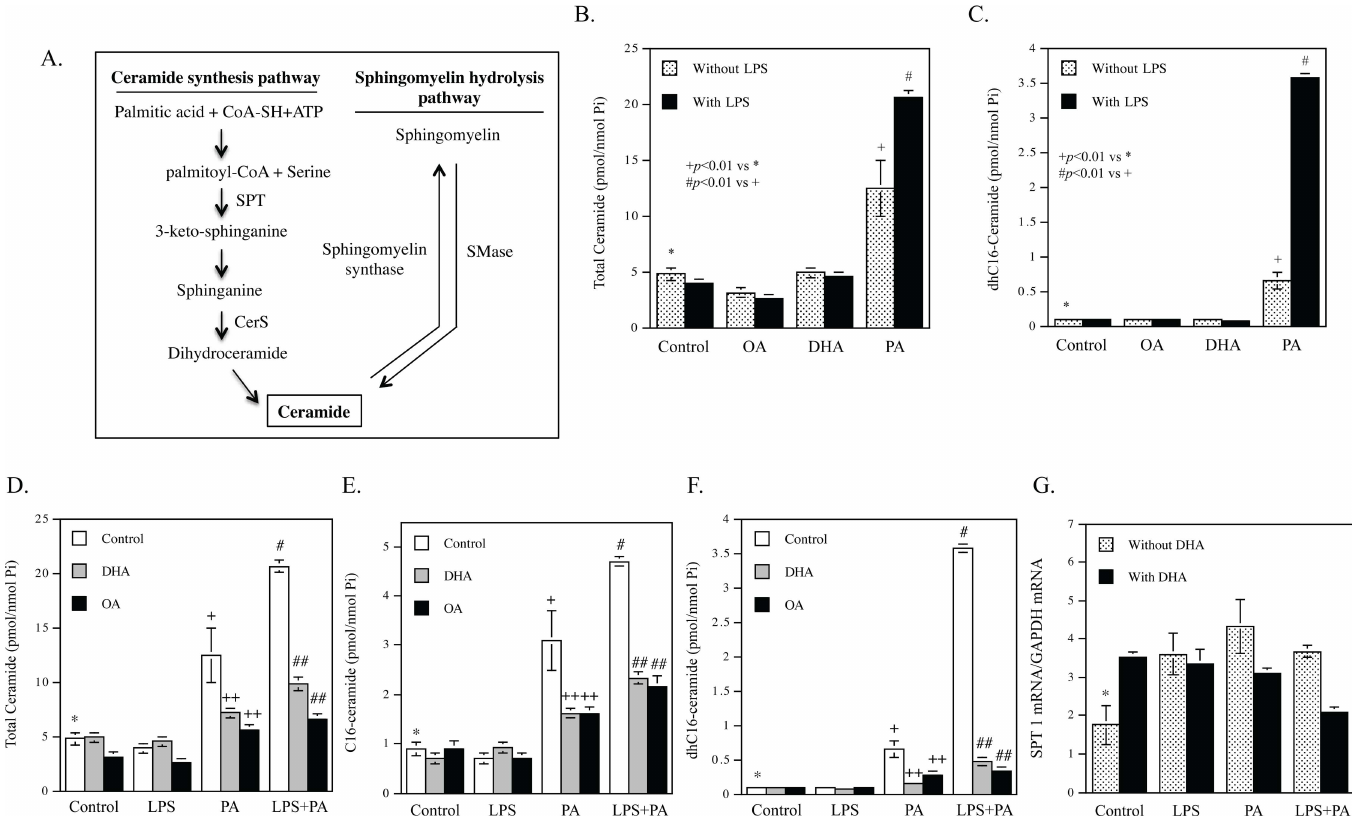
Fig 2. DHA inhibits the CER production increased by LPS and PA. A. Diagram for CER de novo synthesis and sphingomyelin hydrolysis pathways. SPT, serine palmitoyltransferase; CerS, ceramide synthase; SMase, sphingomyelinase. B and C. LPS and PA synergistically stimulate total (B) and dhC16-CER production (C). RAW264.7 macrophages were treated with 100 μ M of OA, DHA or PA in the absence or presence of 1 ng/ml of LPS for 12 h. After treatment, total and dhC16-CER were quantified using lipidomics. + vs. (cid:3) , p < 0.01; # vs. +, p < 0.01. D-F. Either DHA or OA inhibited PA- or LPS plus PA-stimulated CER production. RAW264.7 macrophages were treated with 1 ng/ml LPS, 100 μ M PA or both LPS and PA in the absence or presence of 100 μ M DHA or OA for 12 h. After treatment, total CER (D), C16-CER (E) and dhC16-CER (F) were quantified using lipidomics. + vs. (cid:3) , p < 0.01; # vs. +, p < 0.01; ++ vs. +, p < 0.01; ## vs. #, p < 0.01. G. DHA inhibits SPT1 mRNA expression stimulated by LPS and PA. RAW264.7 macrophages were treated with 1 ng/ml LPS, 100 μ M PA or both LPS and PA in the absence or presence of 100 μ M of DHA for 12 h. After treatment, SPT1 mRNA was quantified using real-time PCR. (cid:3) vs. +, p < 0.05; (cid:3) vs. #, p < 0.05; (cid:3) vs. ^, p < 0.05; ^^ vs. ^, p <